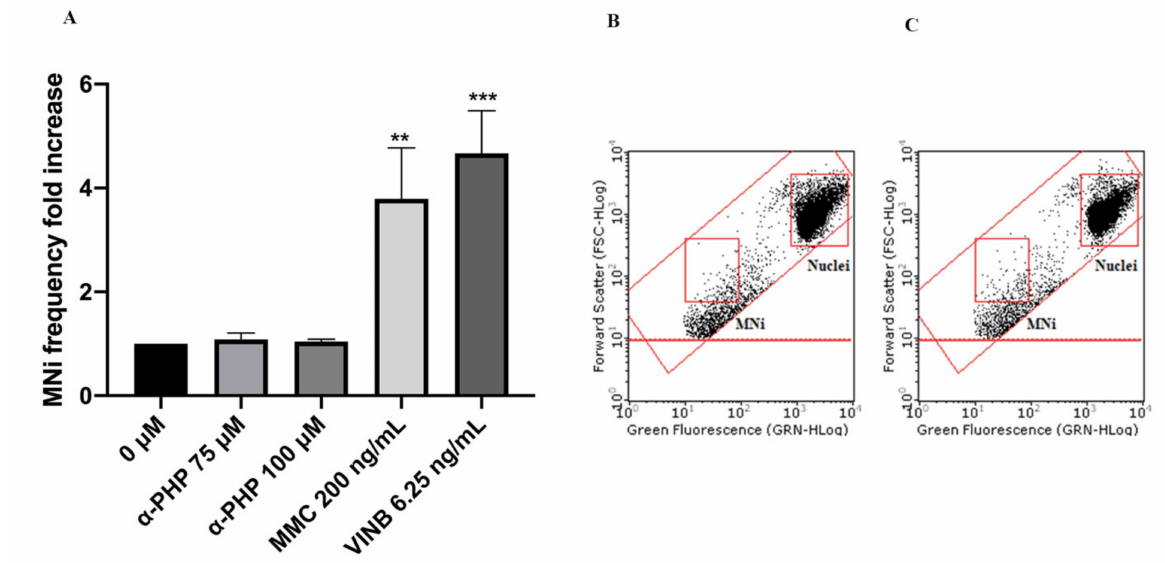
Figure 5. MNi frequency fold increase on TK6 cells after 26 h treatment with α -PHP at the indicated concentrations compared to the negative control [0 µ M] and to positive controls [MMC and VINB] ( A ), plot of nuclei and MNi in the negative control ( B ) and in 100 µ M α -PHP-treated cultures ( C ). Each bar represents the mean ± SEM of five independent experiments. Data were analyzed using repeated ANOVA followed by Bonferroni post-test. ** p < 0.01 vs. 0 µ M; *** p < 0.001 vs. 0 µ